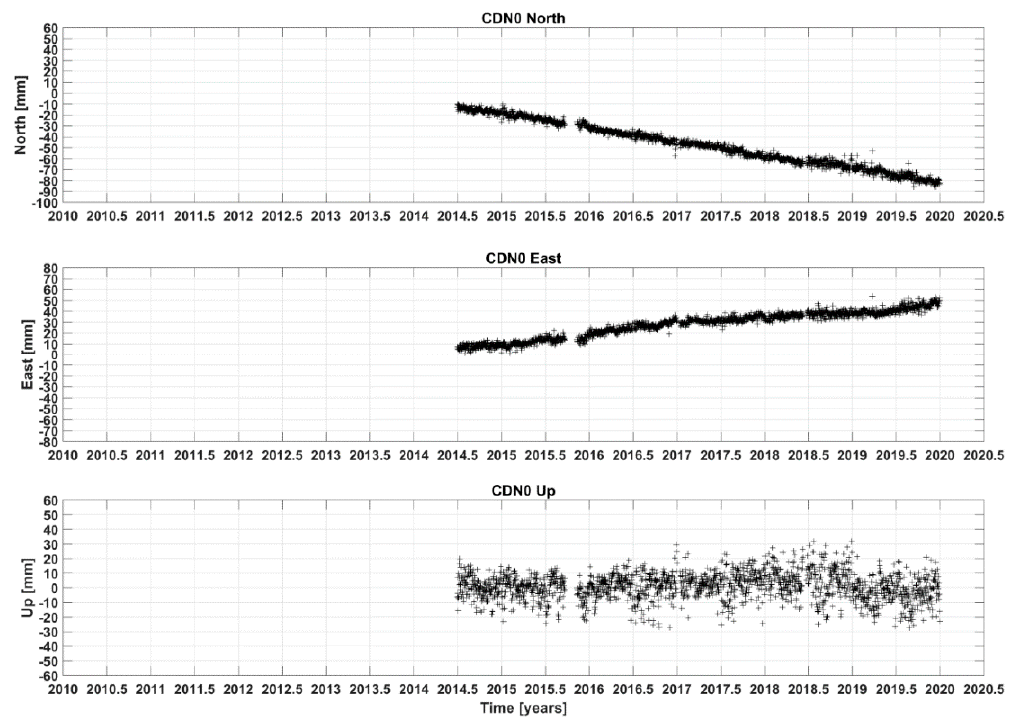
Figure 2. The time series of the North, East, and Up components of the CDN0 GNSS coordinates. The reference frame implemented is ITRF2014.